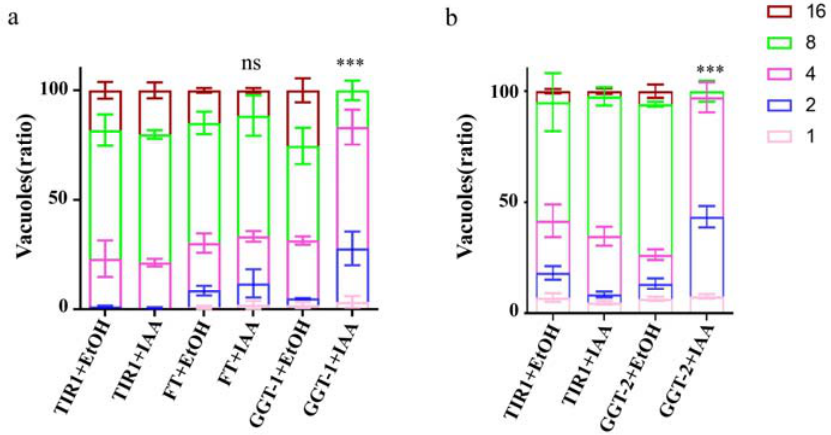
Figure 4. GGT-1 and GGT-2 regulated the replication of parasites. ( a ) The replication analysis of FT and GGT-1. ( b ) The replication assay of GGT-2. IFA was carried out after the parasites grew in HFF with IAA for 24 h. GAP45 was utilized to stain the outline and at least 200 parasitophorous vacuoles were calculated. Data were representative of three independent experiments and the values presented the means ± SEM ( *** p < 0.001, ns: not signi fi cant).